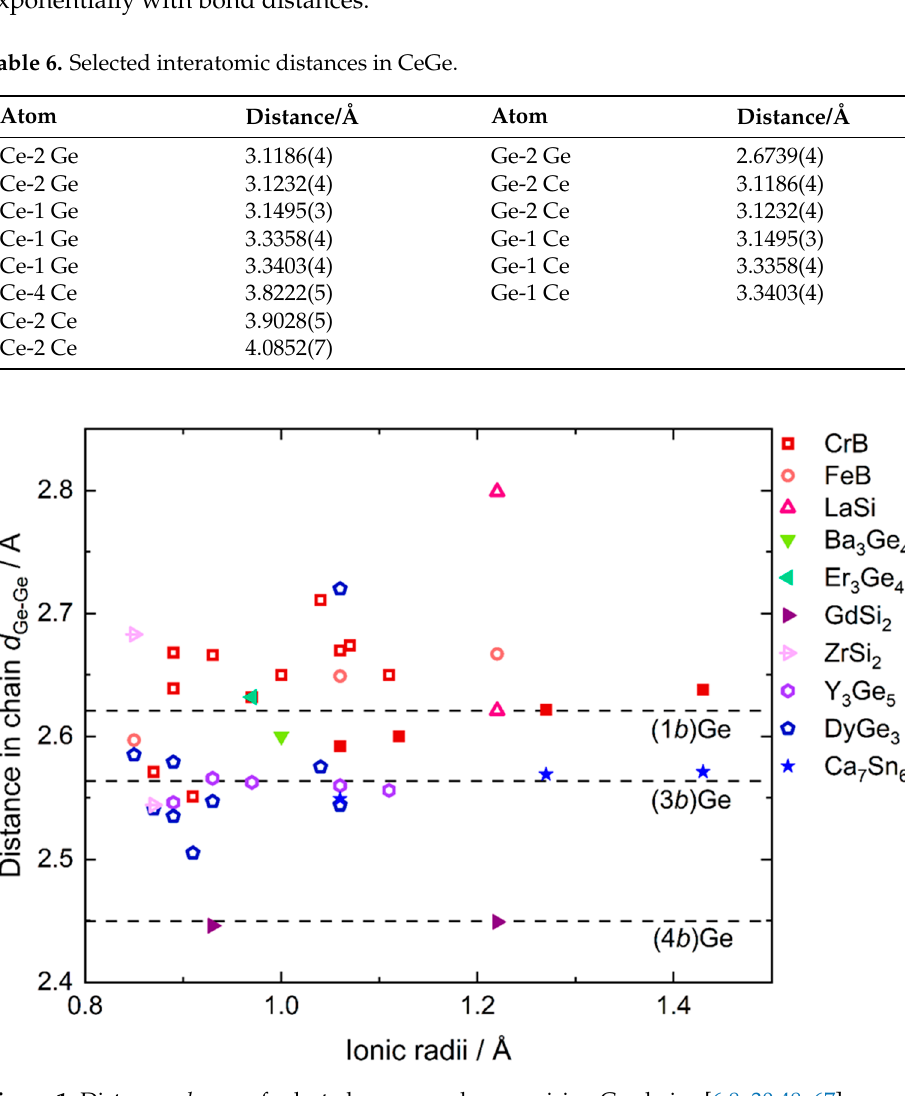
Figure 1. Distances d Ge-Ge of selected compounds comprising Ge-chains [6,8–30,48–67] versus ionic radii (for trivalent rare earth and divalent alkaline earth metals, as well as Eu [68]), ordered by their structure types. Filled symbols denote electron-precise compounds, empty symbols compounds with non-electron precise electron balances. Distances for (4 b )Ge ( cF 8-Ge [46]), (3 b )Ge (NaGe [69]), and (1 b )Ge (Li 7 Ge 2 [70]) serve as references.